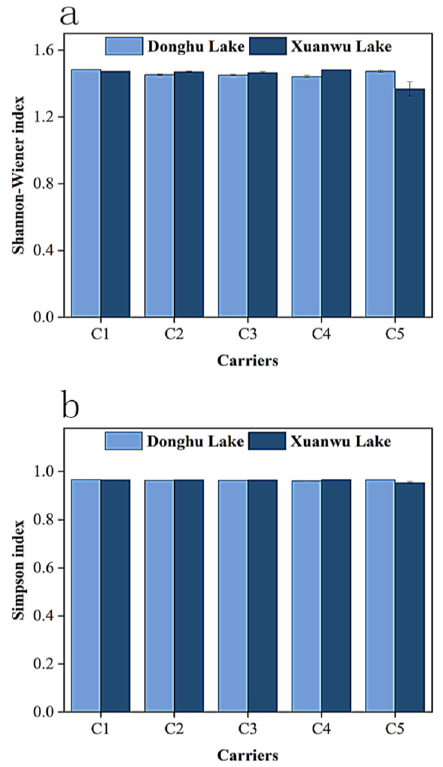
Figure 6. The Shannon-Wiener index ( a ) and Simpson index ( b ) of biofilm attached to five carriers with different specific surface areas (C1–C5) in two incubation sites, including Donghu Lake and Xuanwu Lake.